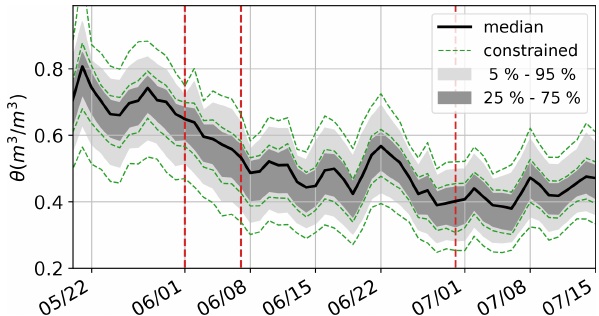
Figure 7. Catchment-wide median (black line), interquartile range (dark shadow), and inner 90% (light shadow) of daily soil mois- ture values obtained from unconstrained interpolation. The dashed green lines indicate the corresponding percentiles (5th, 25th, 75th, and 95th) obtained from constrained interpolation ”(the median of the constrained interpolation is not shown in addition as it is almost identical to the unconstrained interpolation); the dashed red lines show dates used in Fig.